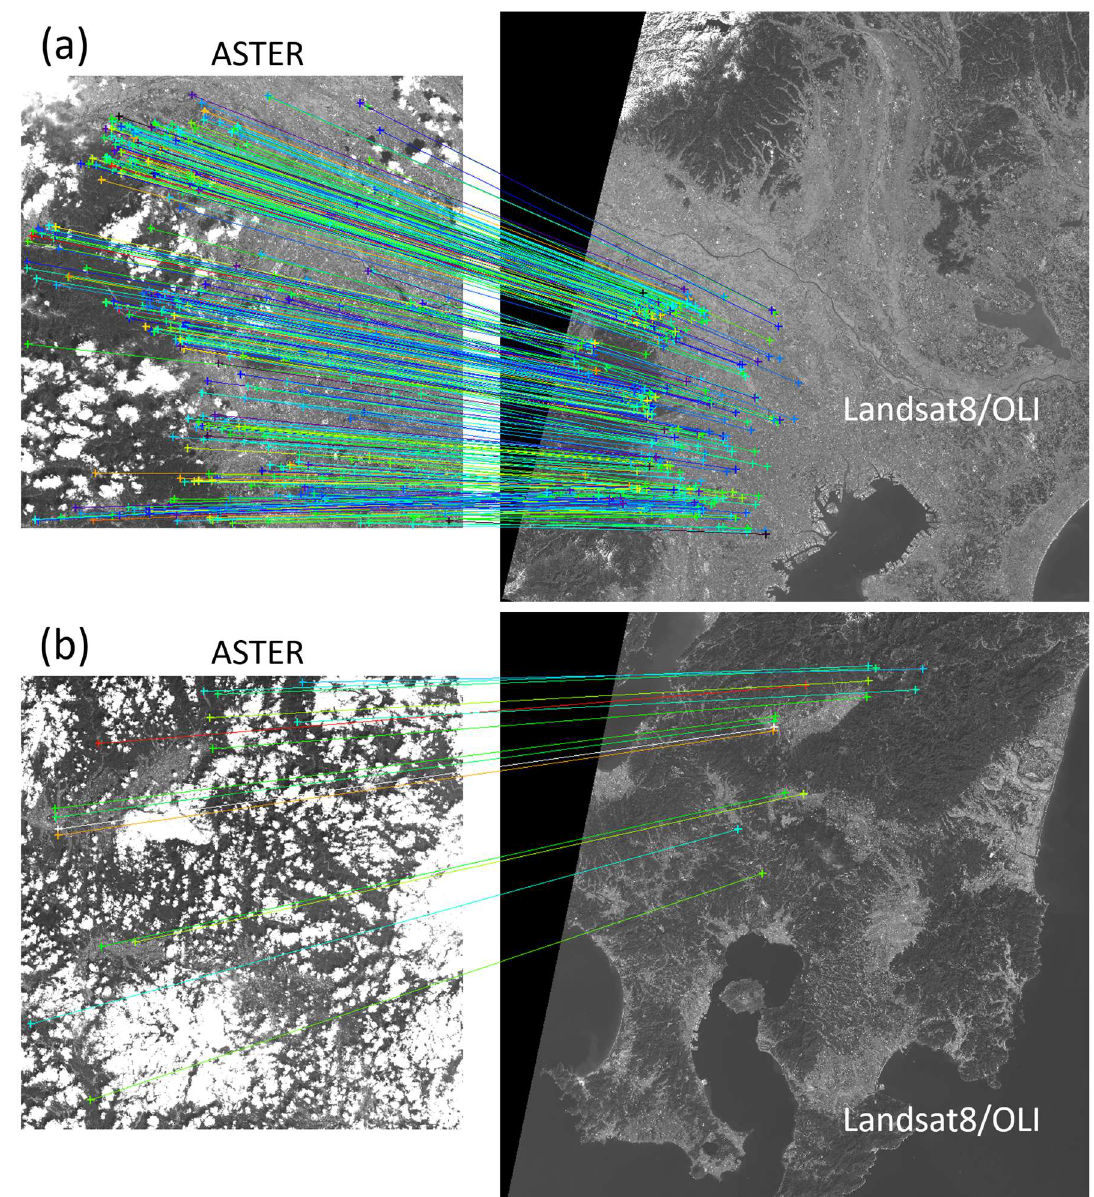
Figure 4. Same as Figure 3 but eliminating incorrectly matched pairs based on a robust feature-matching method [9].